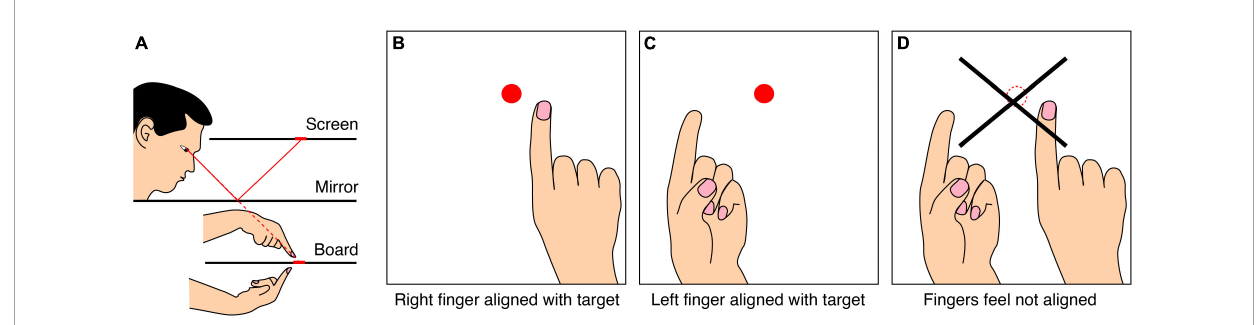
FIGURE7 Schematic representation of an experiment showing an inconsistency in sensory alignment of the tips of invisible fingers. (A) The set-up used (Kuling et al., 2017). When the right index-finger feels as if it is at the location of a visual target (B) , and the left finger feels as if it is at the same visual location (C) , the two fingers in general do not feel aligned (D)